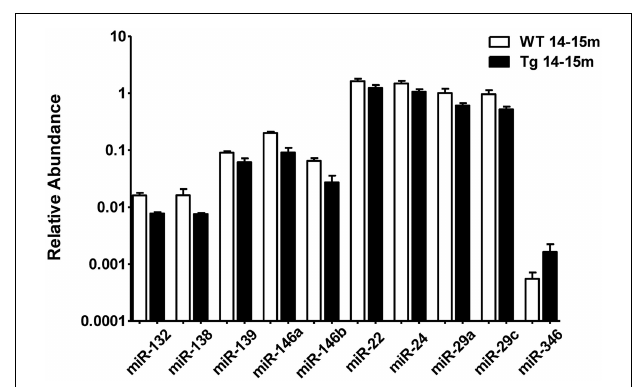
FIGURE 3 | Significant age-dependent changes in plasmatic miRNAs in the 3xTg-AD analyzed by qRT-PCR. The graph depicts the relative abundance (mean ± SD) of each one of the miRNAs that show statistically significant differences ( t -test; p < 0 . 05) in plasma levels between the 2–3 and the 14–15 months-old 3xTg-AD mice. Relative abundances were calculated with the difference of the Ct of each miRNA and the Ct of the miR-39 of C. elegans mimics ( (cid:2) Ct) using the formula 2 − (cid:2) Ct . Determination of circulating miRNA profiles included plasma samples from six-seven animals per group and a total of four experimental groups were integrated: 2–3 months old-3xTg-AD mice ( n = 3), 2–3 months old-WT mice ( n = 3), 14–15 months old-3xTg-AD ( n = 3), and 14–15 months old-WT mice ( n = 3) ( n = samples).